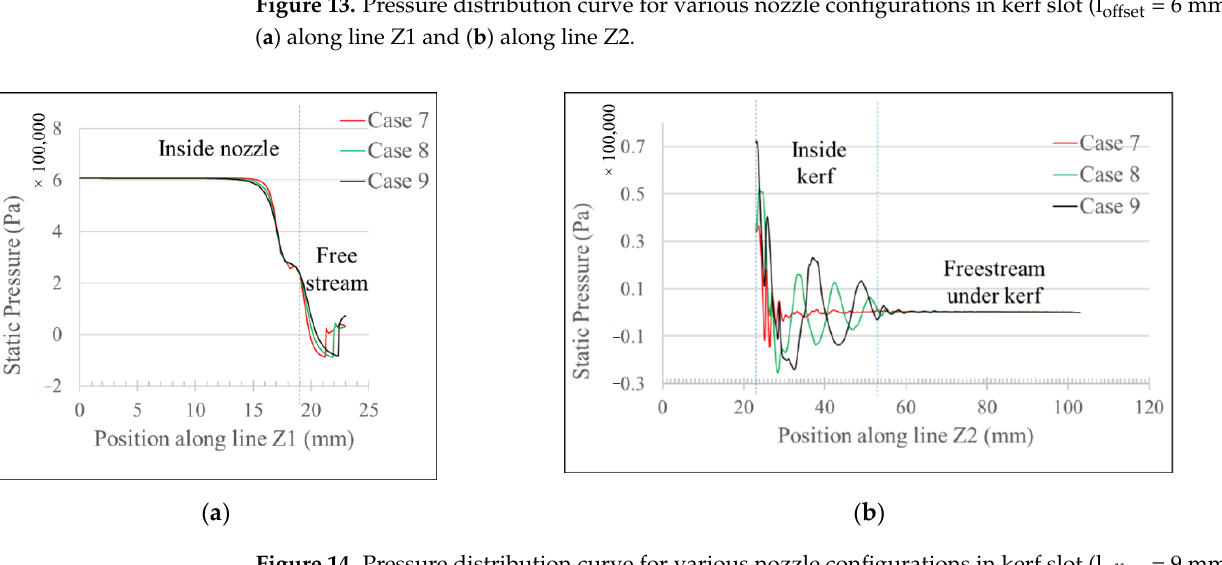
Figure 14. Pressure distribution curve for various nozzle configurations in kerf slot (l offset = 9 mm): ( a ) along line Z1 and ( b ) along line